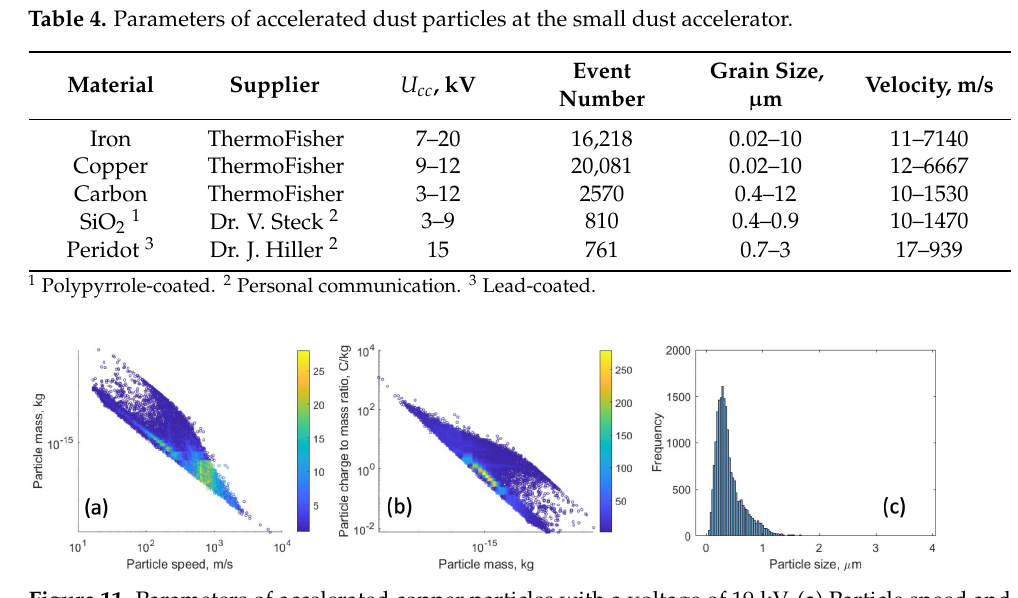
Figure 11. Parameters of accelerated copper particles with a voltage of 19 kV. ( a ) Particle speed and mass distribution; ( b ) Particle charge-to-mass ratio varies with mass; ( c ) Particle size distribution. We observed single particles of polypyrrole-coated SiO 2 and lead-coated peridot.